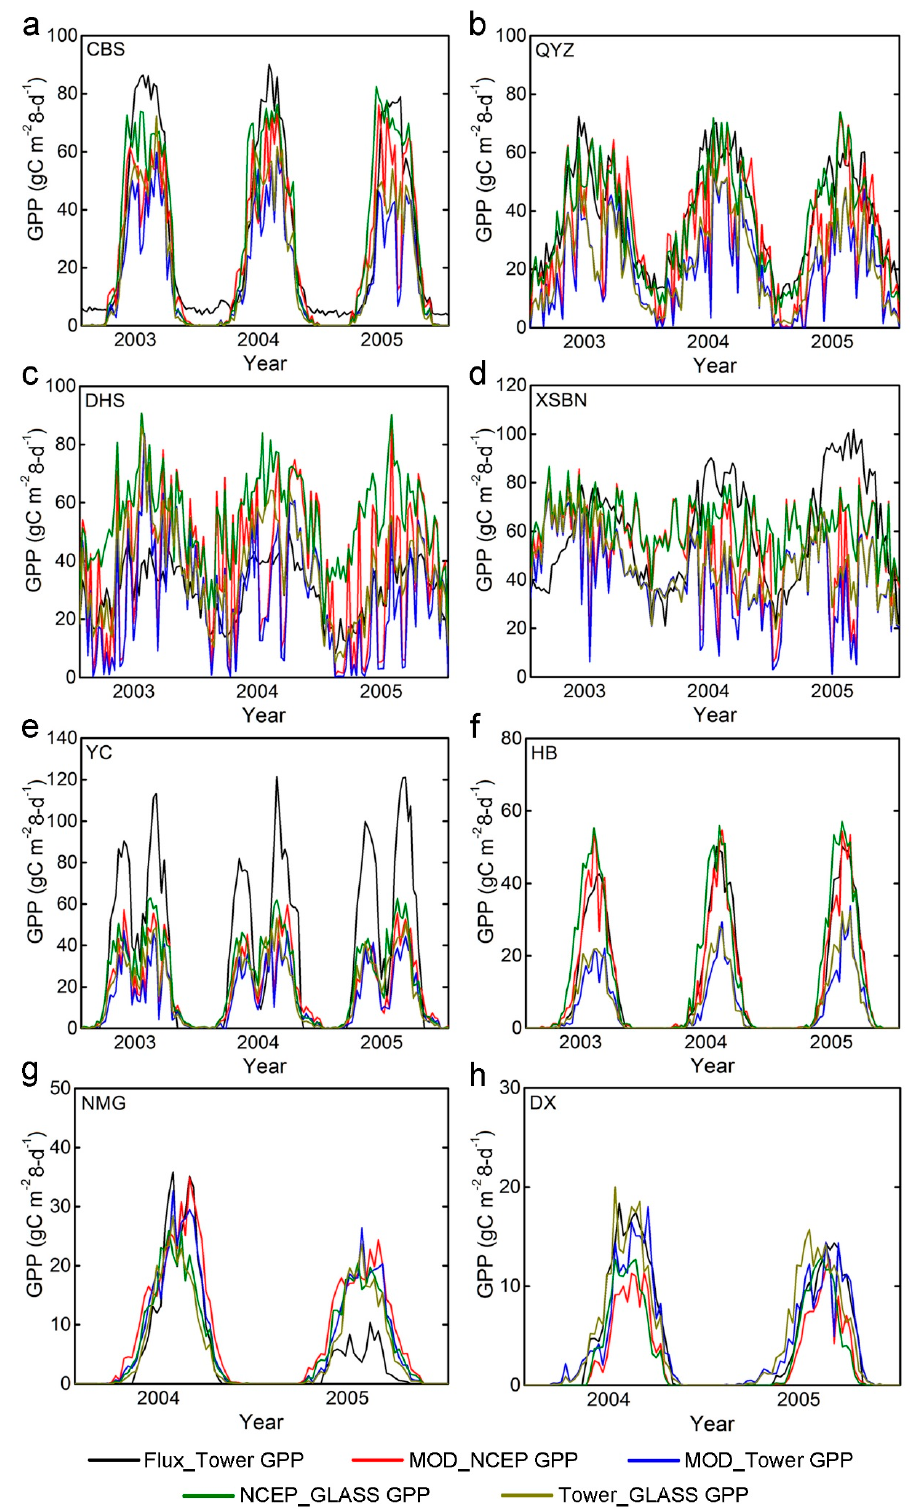
Figure 3. Time series of eight-day GPP derived from the tower estimates ( i.e. , Flux_Tower GPP) and four different experimental groups ( i.e. , MOD_NCEP GPP, MOD_Tower GPP, NCEP_GLASS GPP and Tower_GLASS GPP) at: ( a ) CBS forest site; ( b ) QYZ forest site; ( c ) DHS forest site; ( d ) XSBN forest site; ( e ) YC cropland site; ( f ) HB grassland site; ( g ) NMG grassland site; and ( h ) DX grassland site. The full name for each site is listed in Table 1.